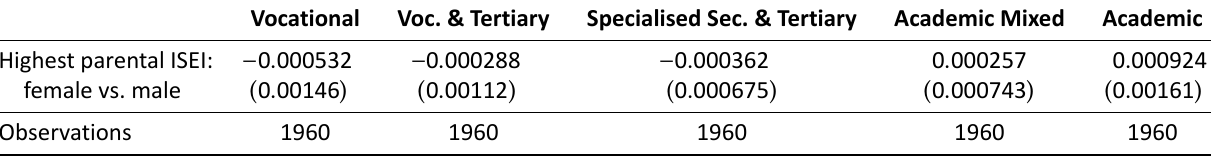
Table 6. Contrast in average marginal effect of parental ISEI (female vs. male).